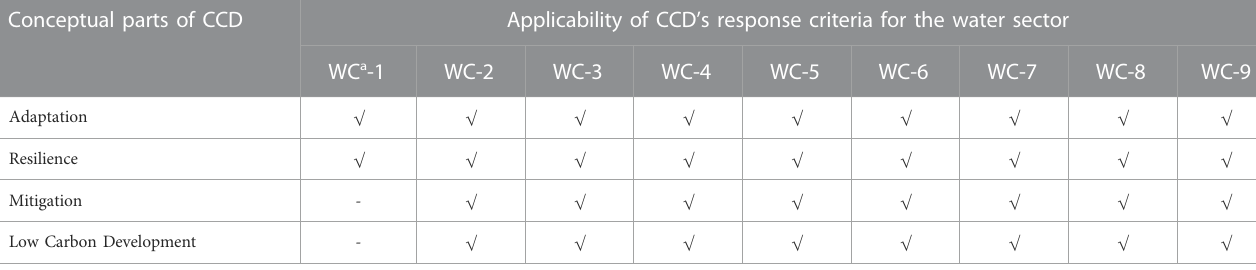
TABLE 1 Direct and indirect linkages of criteria with conceptual parts of CCD [Source: (Iqbal, 2021)]. Conceptual parts of